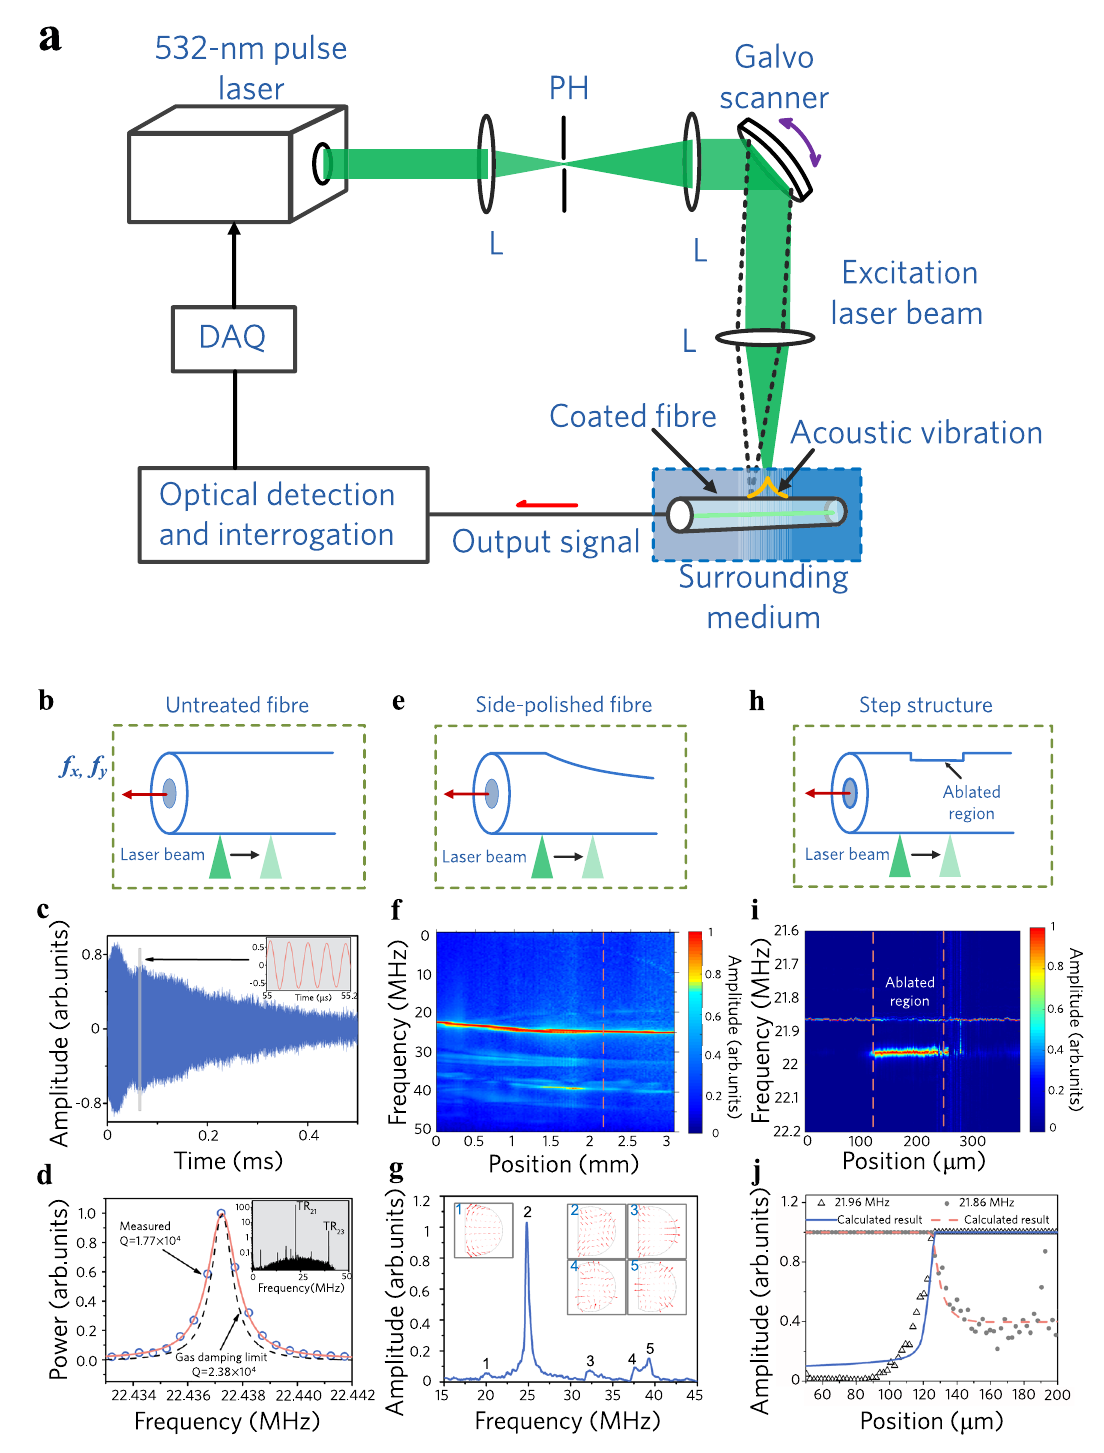
Fig. 2 PTAV characterization and optoacoustic sensing in air. a Experimental setup. DAQ data acquisition module, L Lens, PH pinhole. A uniform fi bre ( b ), a side-polished fi bre ( e ) and a partially laser-ablated fi bre ( h ) are used in optoacoustic sensing. c Measured ring-down waveform. Sampling rate: 100 MHz; detection bandwidth: 50 MHz. Inset: temporal signal within the grey box time window. d Acoustic spectrum of the TR 21 mode. Inset: measured spectrum at the full frequency scale, in which the TR 21 and TR 23 modes can be observed. f Measured spectrogram of the side-polished fi bre. g Acoustic spectrum at z = 2.05 mm (labelled by the vertical dashed line in ( f )). Inset: calculated transverse mode pro fi les. Arrows represent local displacements. i Spectrogram measured by scanning the PTAV over the step structure. The two vertical dashed lines mark the steps. j Comparison of the variations in the resonance strength of the two resonance peaks at the left edge of the